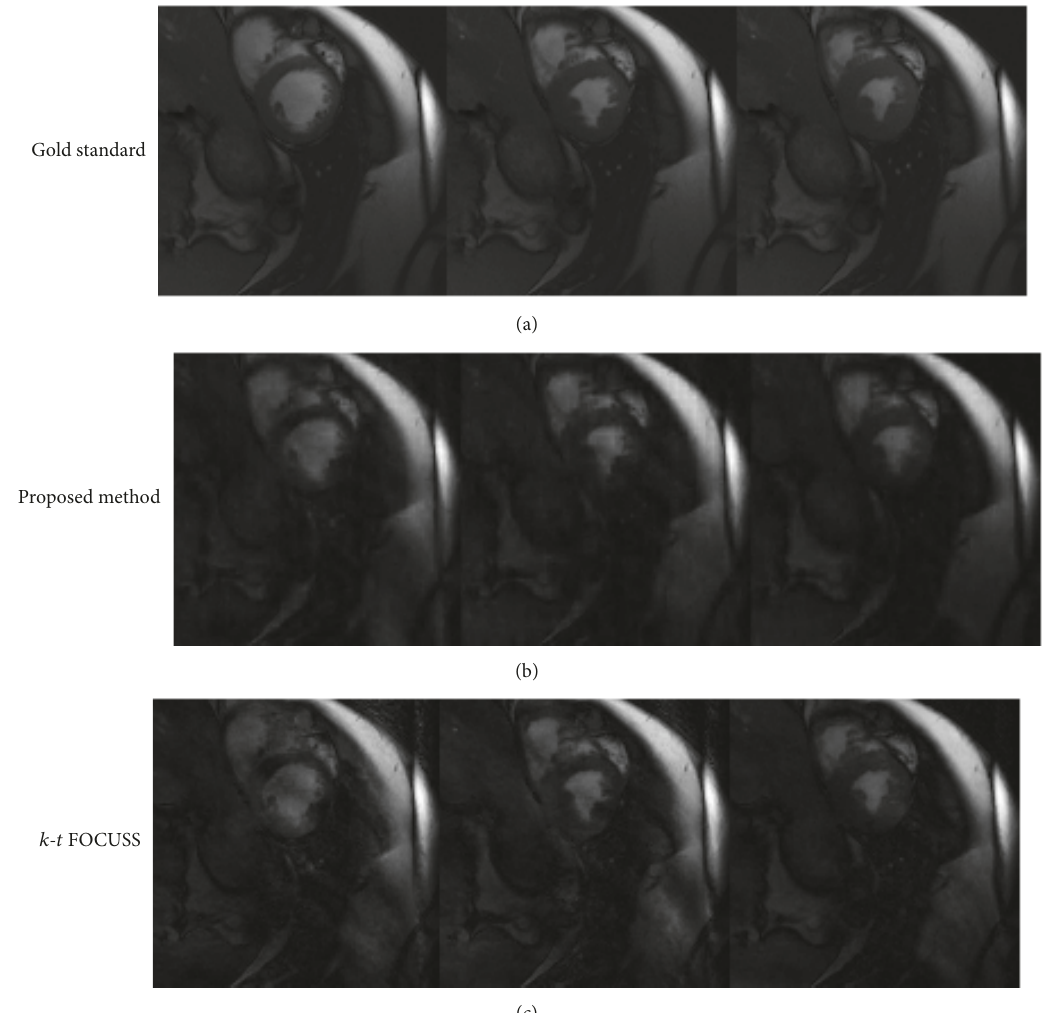
Figure 5: Comparison of recovered images in pixel domain for proposed method and k-t FOCUSS with MEMC data at a reduction factor of 4. (a) Fully sampled breath held k -space data. (b) Recovered images with proposed method. (c) Reconstructed images for k-t FOCUSS with